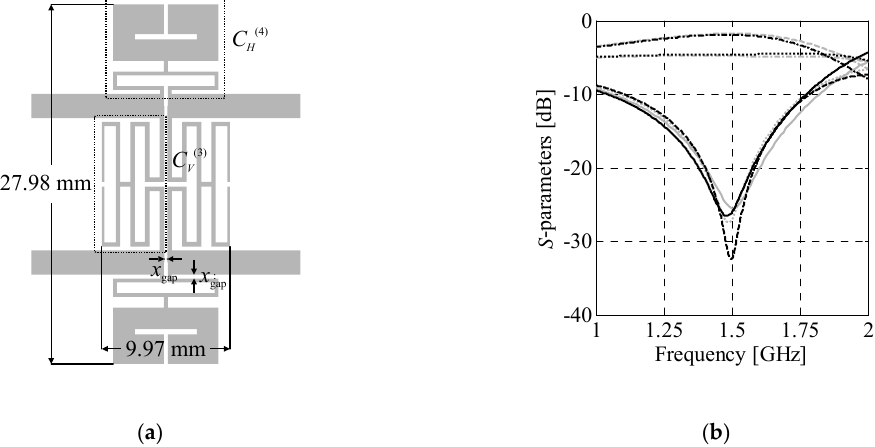
Figure 12. Optimized BLC: ( a ) geometry and ( b ) comparison of the high-fidelity EM model B A responses: S 11 (–), S 21 (– –), S 31 (–·), S 41 (···) obtained using Keysight ADS (gray) and CST Studio (black). Table 1. Surrogate-Assisted BLC Design: Benchmark Results.